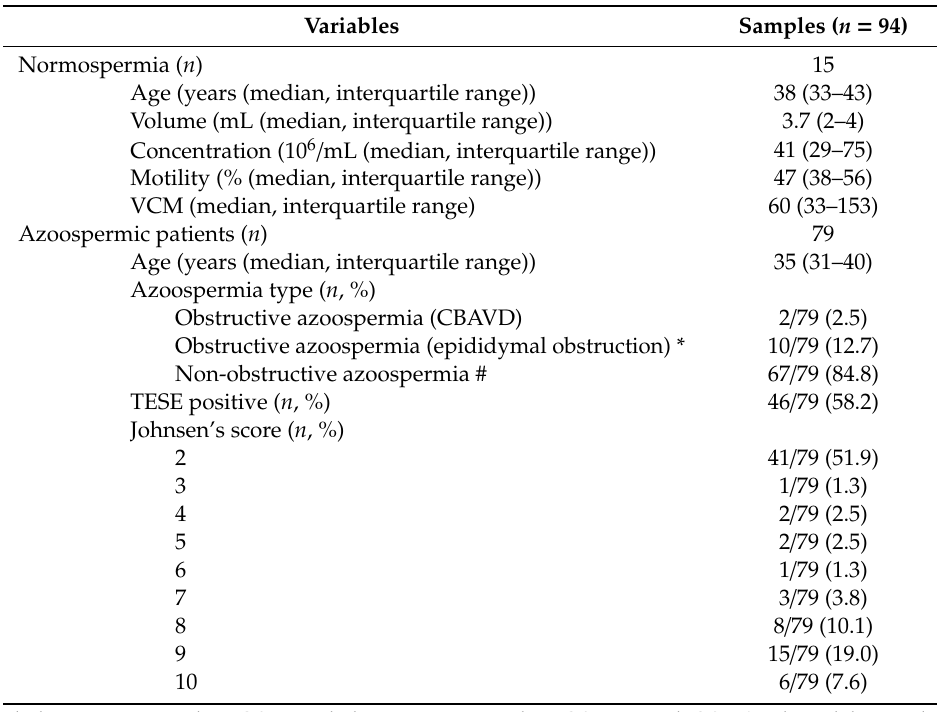
Table 6. Clinicopathological features of the seminal plasma